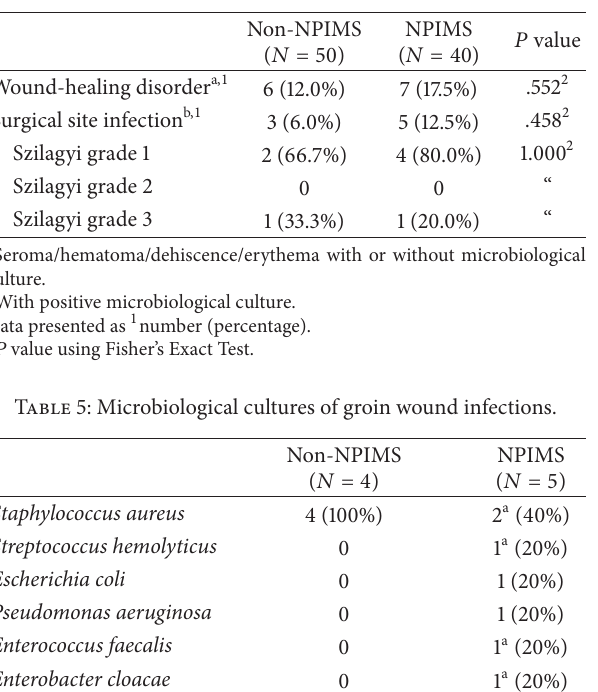
Table 3: Perioperative characteristics. Table 4: Incidence of postoperative infection and Szilagyi grades of infection.